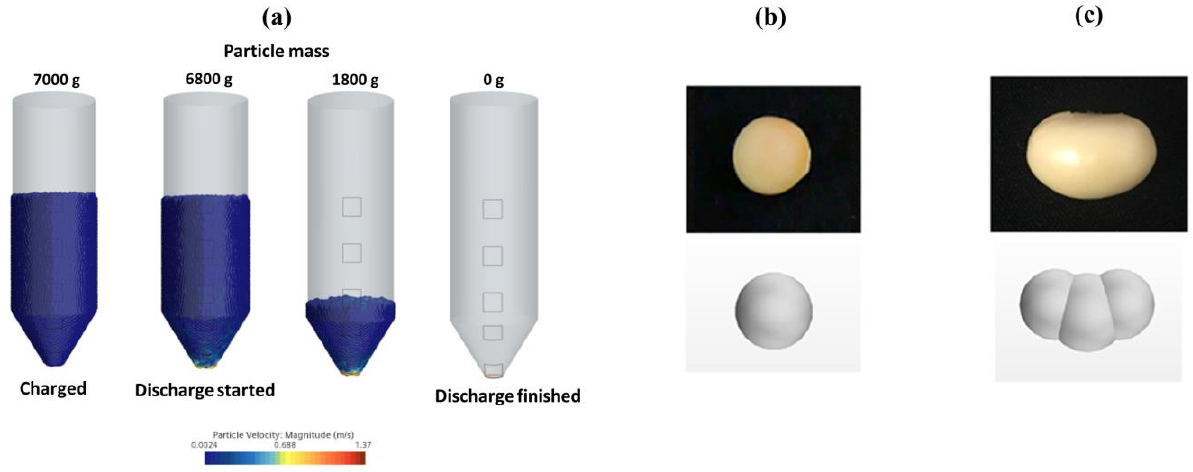
Figure 10. Discharge process in the simulation for the soybeans with 12% moisture content at 40 mm orifice size ( a ), and shapes of the soybean particles for DEM simulations of grains with 12% ( b ) and 60% ( c ) moisture contents.